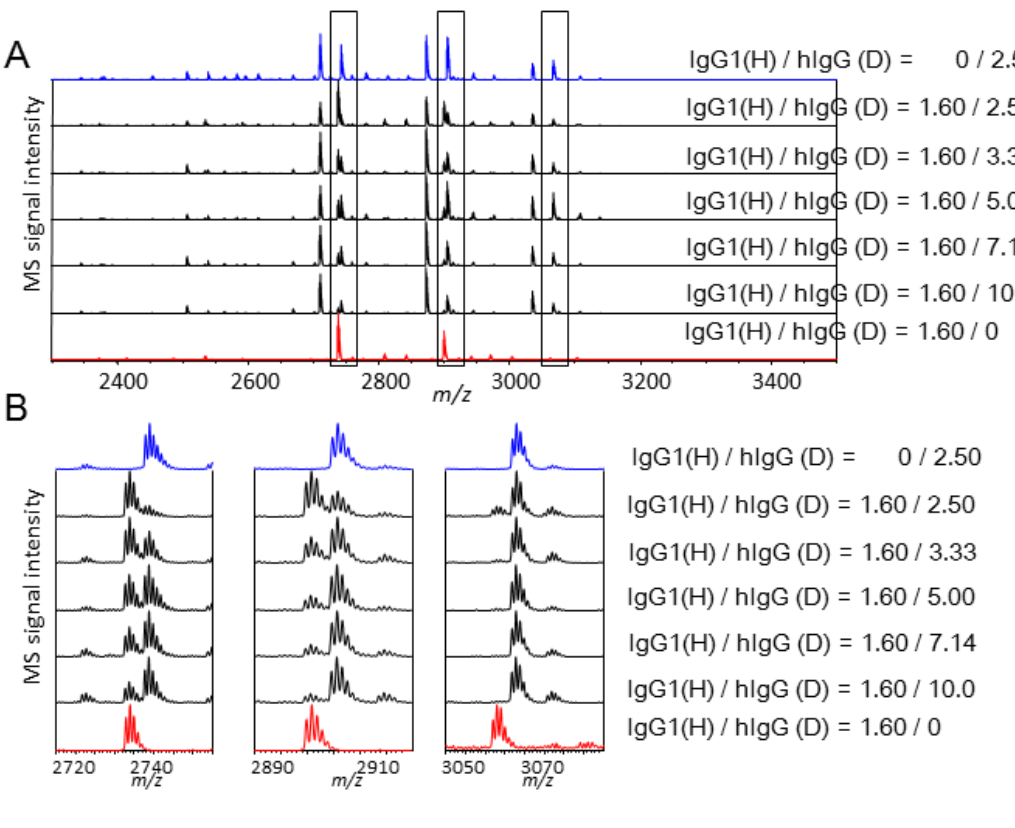
Figure 4. Comparative analysis between IgG1 and hIgG. ( A ) MALDI-TOF MS spectra of different ratio mixtures (0:2.50, 1.60:2.50, 1.60:3.33, 1.60:5.00, 1.60:7.14, 1.60:10.0, 1.60:0 ( μ g/ μ g)) of Bz-labeled IgG1 to d-Bz-labeled hIgG glycopeptides; ( B ) Enlarged spectra of